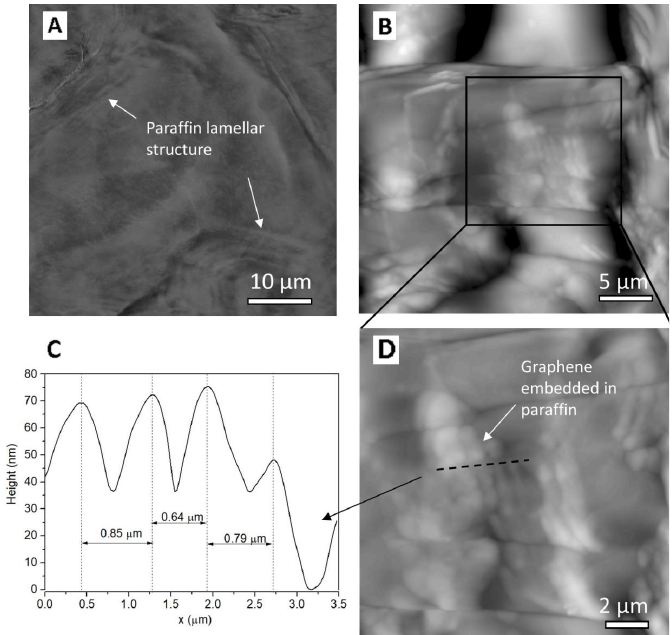
Figure 4. AFM images: ( A ) topography on paraffin sample, scan area 50 µm*50 µm, ( B ) topography on 1% graphene – paraffin composite (PCM-1G) sample, scan area 25 µm*25 µm; ( C ) topography on 1% graphene – paraffin composite (PCM-1G) sample, scan area 10 µm*10 µm, shows carbon struc- tures embedded in paraffin matrix; ( D ) cross-section profile evidencing an interlayer spacing of ap-